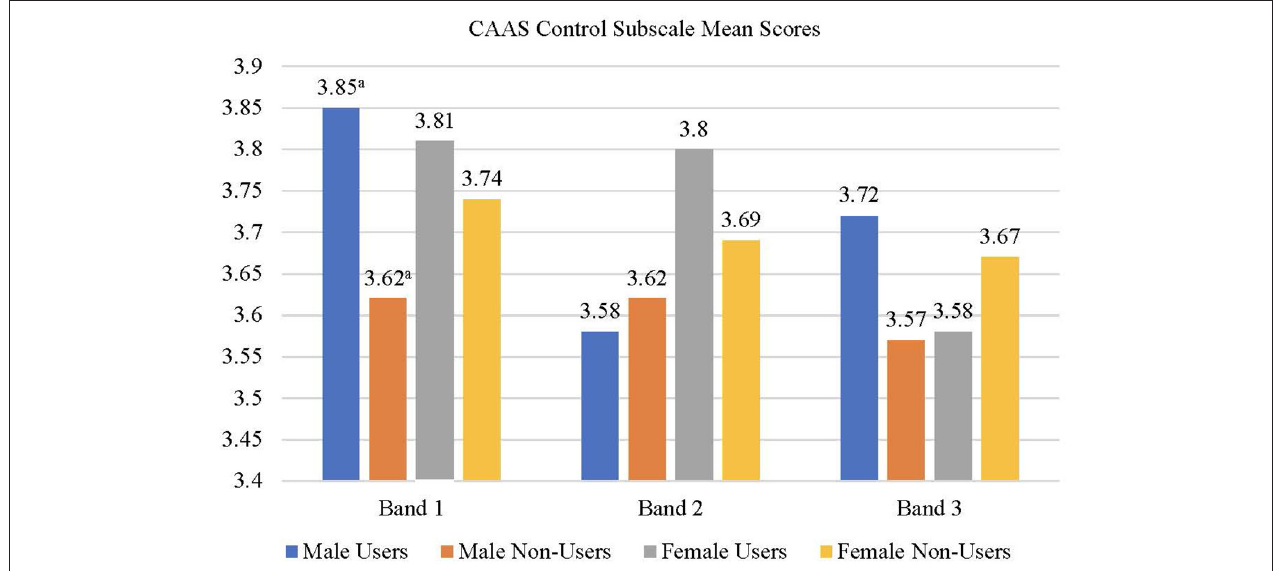
FIGURE 4 | User status × gender × school banding interaction of the CAAS—control subscale. N = 2,935 12th graders (1,549 females and 1,374 males, 12 unidentified; 844 users and 2,091 non-users). CAAS, Career Adaptability Scale. Scores ranged from 1 to 5 with higher scores indicating higher level of adaptability resources. a Male users from band 1 schools had significantly higher scores than male non-users from the same school banding ( p <